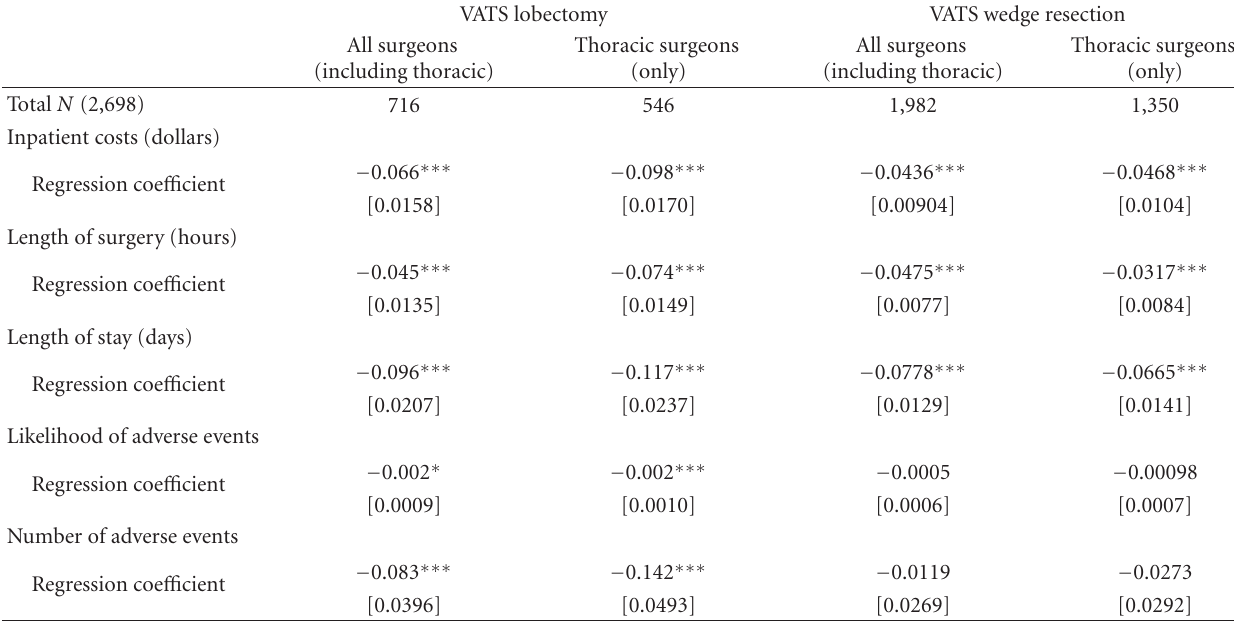
Table 5: Multivariable results for cost, utilization, and adverse